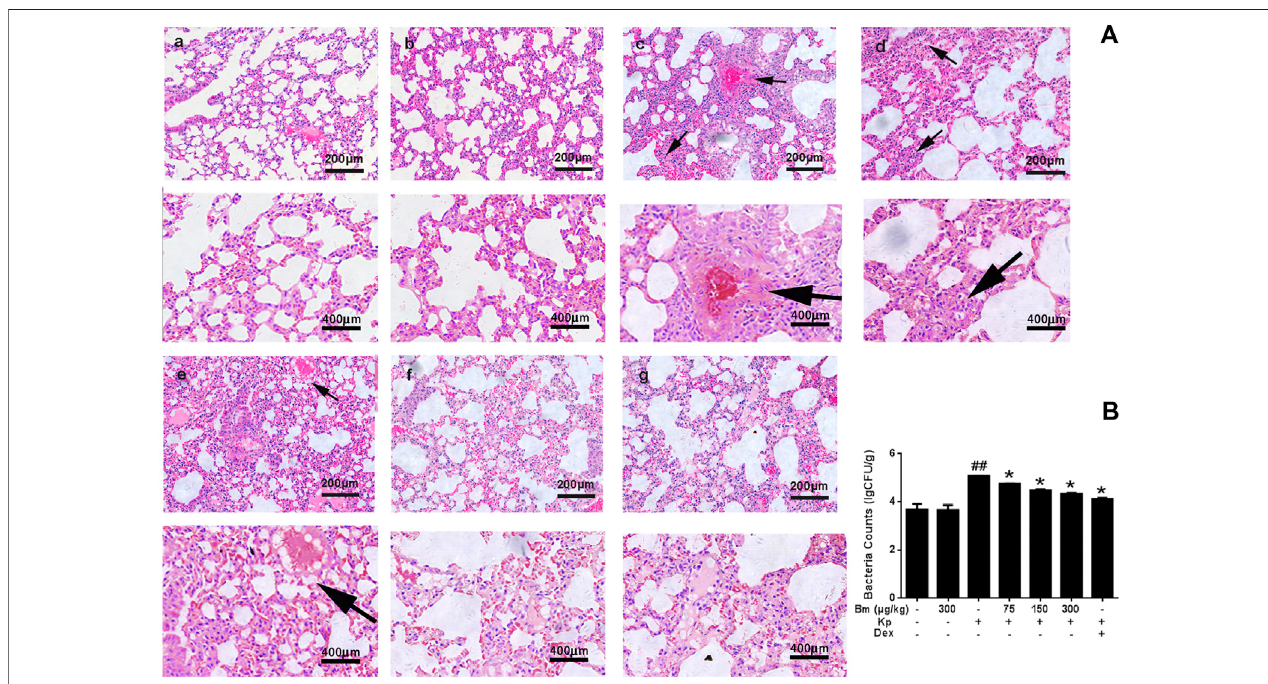
FIGURE 2 | Characterization of lungs from the mouse model (A) Lung tissue structure was observed with H&E staining: a) blank control group, b) Bergenin monohydrate treatment group (300 μ g/kg), c) Klebsiella pneumonia -infected group, e-f) Klebsiella pneumonia -infected mice treated with Bergenin monohydrate (75,